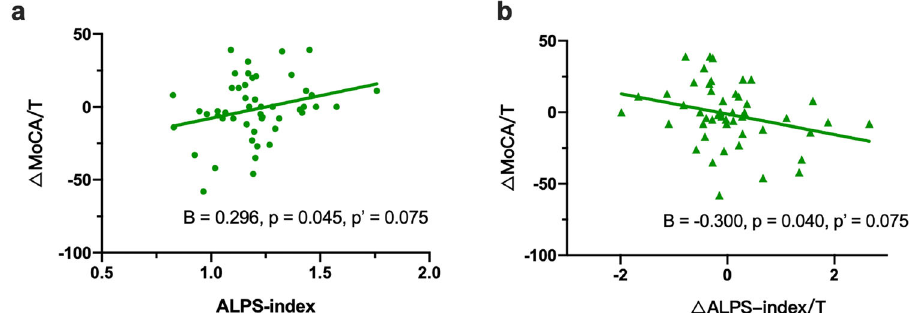
Fig. 3 Correlation between ALPS index and the cognitive progress. In the linear regression model, there was a positive correlation between the baseline ALPS-index value and the Δ MoCA/T score (B = 0.296, P = 0.045, P ’ = 0.075) ( a ) and a negative correlation between the Δ ALPS index/T and the Δ MoCA/T score (B = − 0.300, P = 0.040, P ’ = 0.075) ( b ). P ’ , corrected P .